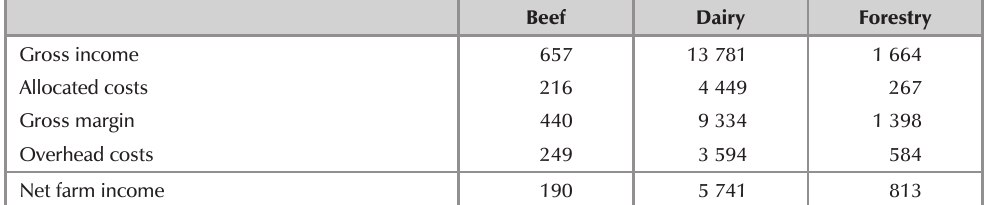
Estimated average gross margin and net farm income (Rands per ha) for three types of enterprises in the study area based on government enterprise budgets and farm data collected in this study. Capital investment costs of enterprises are taken from Finrec, DoA 1998 data. VAD for forestry is taken from Hassan 2000. All values expressed in 2007